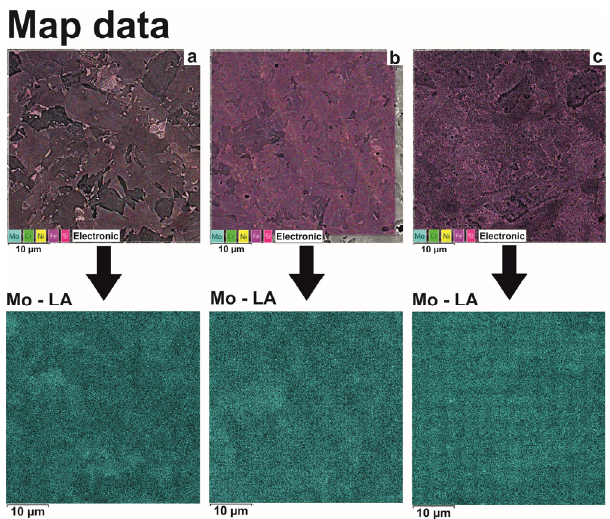
Figure 5. Atom mappings from an analyzed section: ( a ) rolled products; ( b ) T1 (steel in initial state after DLD); ( c ) T3 (DLD + HT).